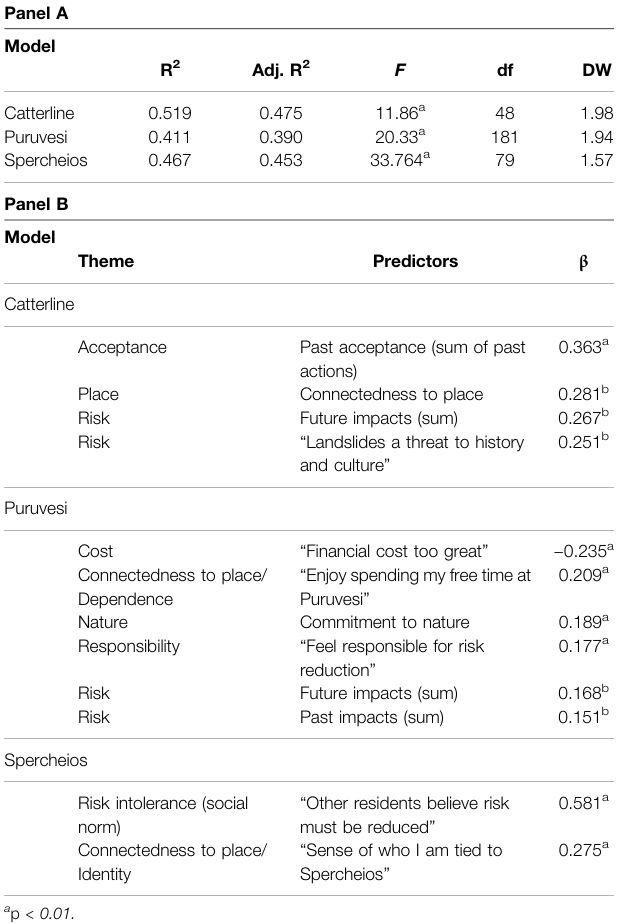
TABLE 7 | Multiple linear regression model results (A) and standardised beta ( β ) coef fi cients (B) using attitudinal factor scores and risk, nature, and place survey variables as independent variables and behavioral acceptance scores as the dependent variable in each study